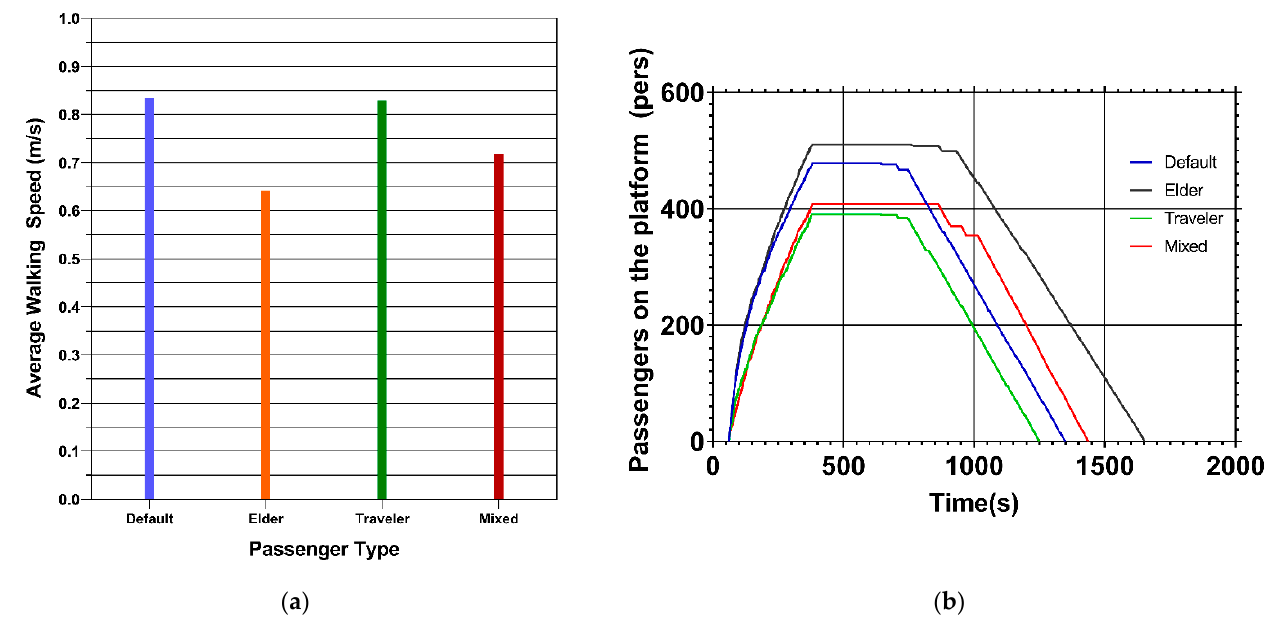
Figure 5. ( a ) Average passenger walking speed and ( b ) evacuation times for each passenger profile. As shown, the mixed population has lower average walking speed than the default and traveler group. As for the evacuation times, travelers may have the same speed as the default passengers, but their dimensions do not allow for a higher flow rate through the train doors. This limits the number of passengers that can evacuate to the platform in a given time.